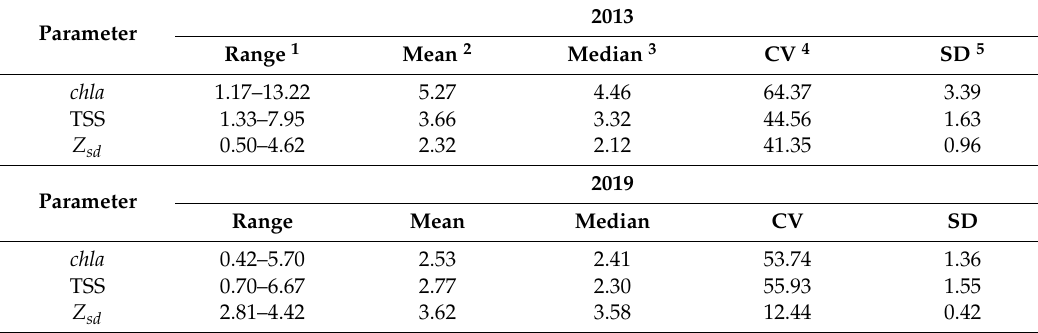
Table 4. Summary for chla , TSS and Z sd values